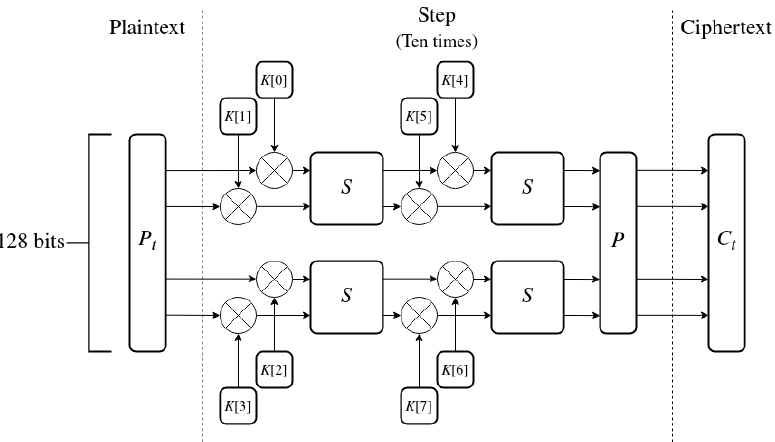
Figure 8. The encryption algorithm of IJON.